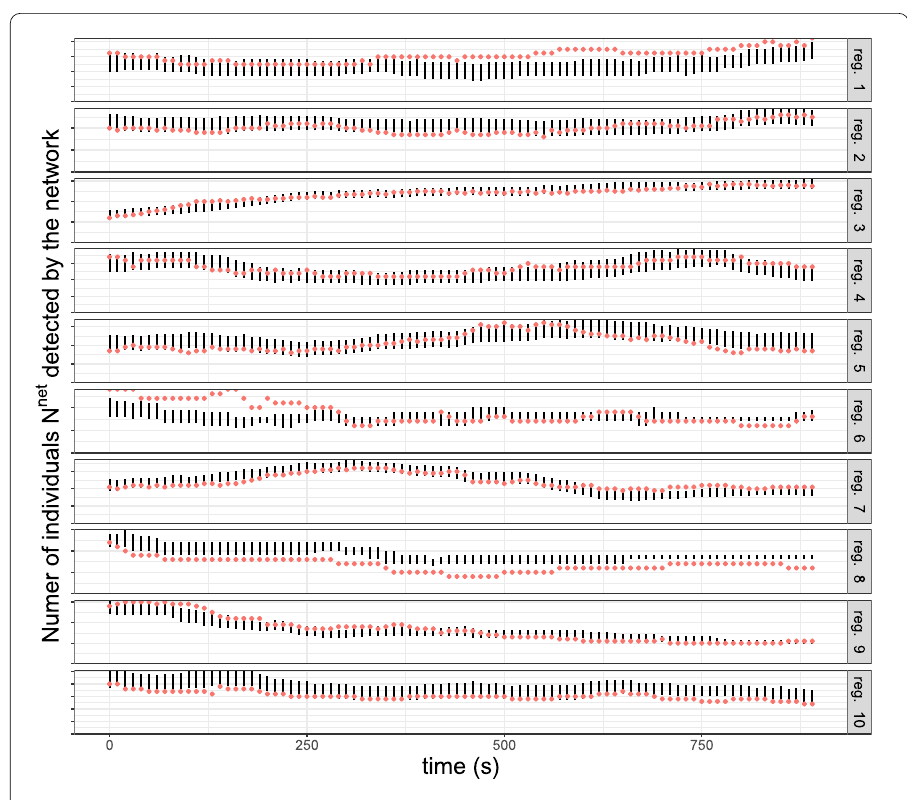
Figure 12 Credible intervals for the number of individuals ¯ N net t per region. Credible intervals (prob = 95%) for the number of individuals ¯ N net t per region detected by the network compared to true values (in red) computed according to the distribution in eq. (15) using the RSS geolocation model with uniform prior